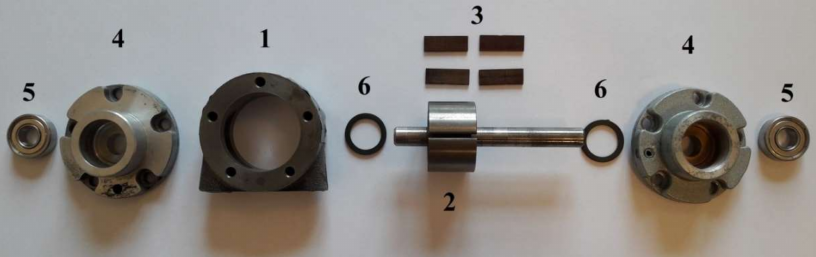
Figure 1. A general view of the expander. (1) cylinder; (2) rotor; (3) vanes; (4) end covers; (5) rolling bearings; (6)